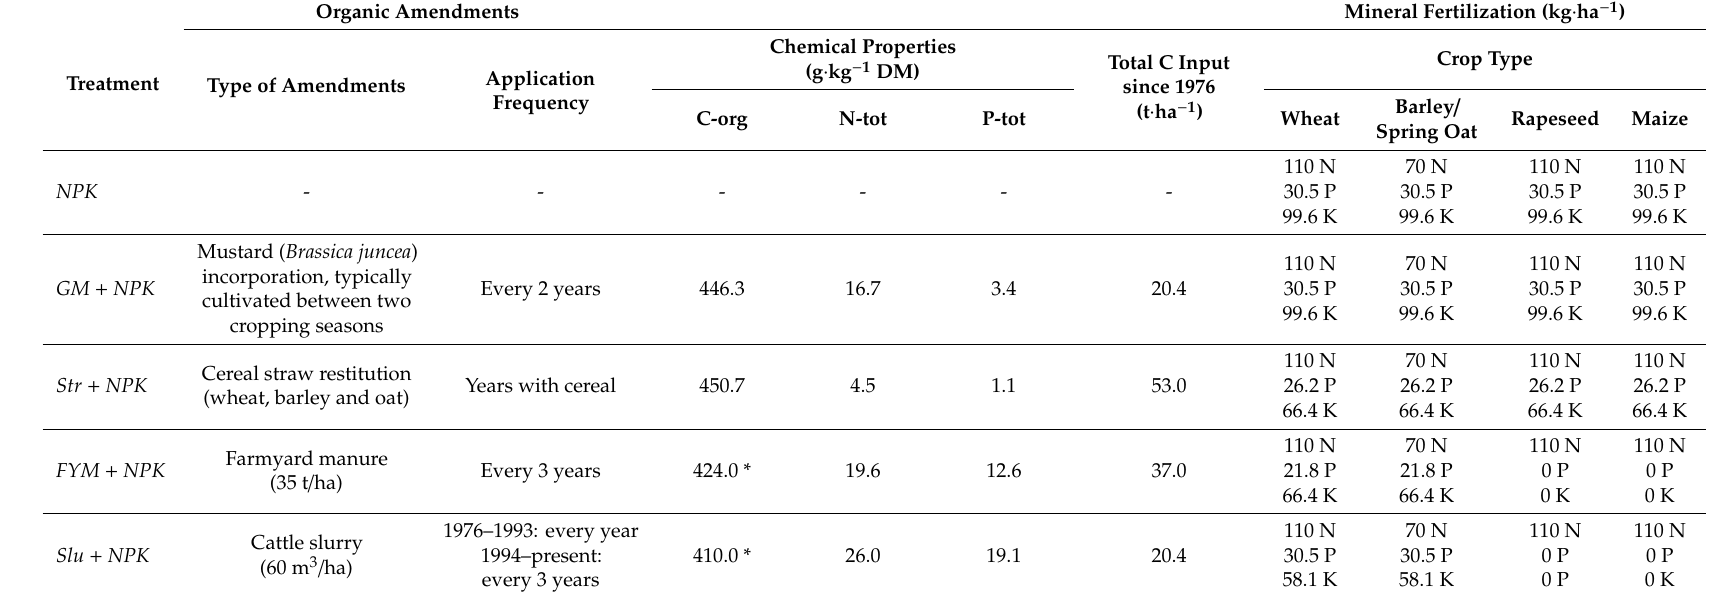
Table 1. Description and characterization of all the fertilization